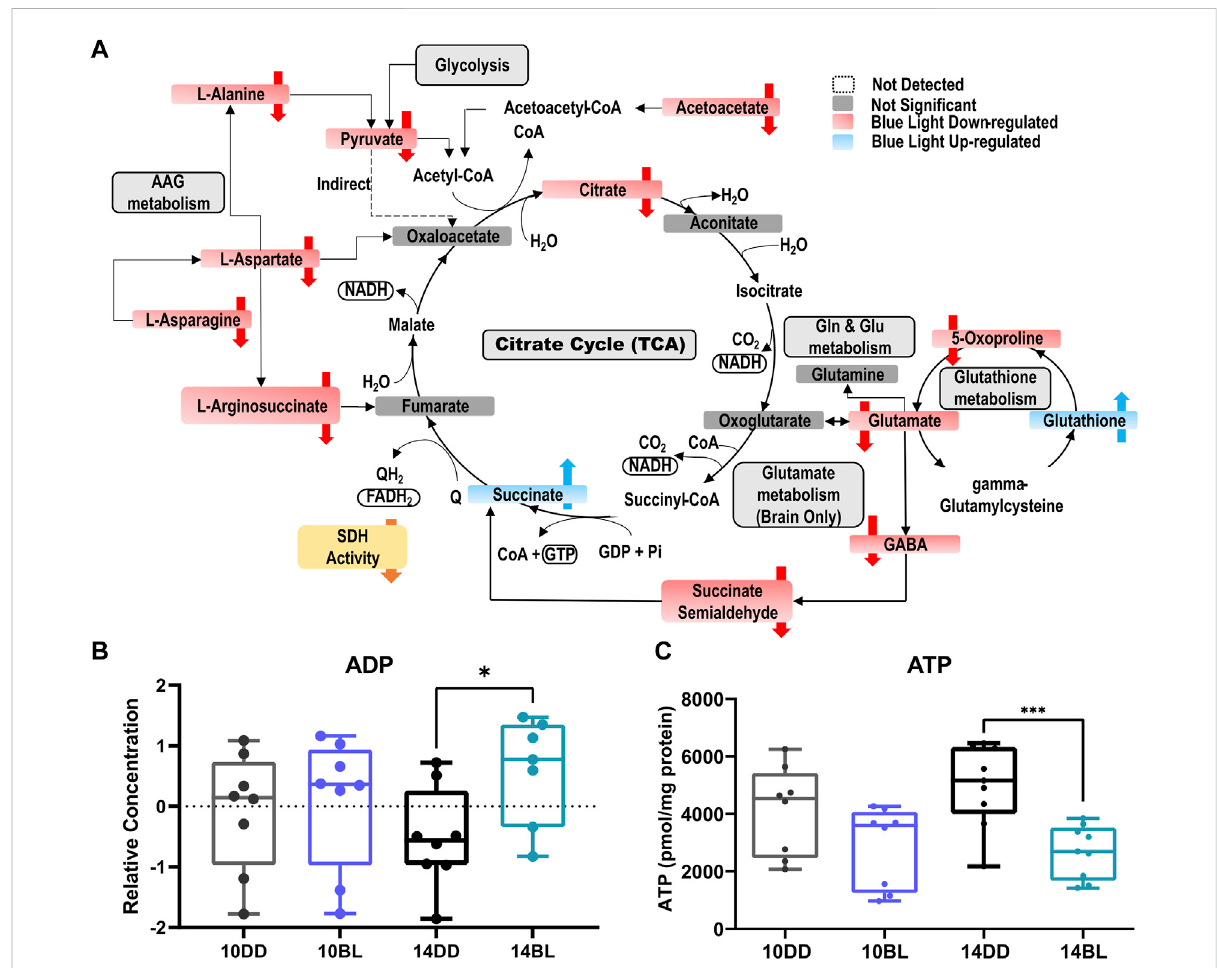
FIGURE 5 Schematicoverview of the metabolic pathways most affected by chronic BL in heads of eya 2 fl ies. (A) Downregulated metabolites are shown in red, and upregulated metabolites in blue. (B) Box plots for ADP levels after 10 or 14 days of chronic BL. (C) ATP levels in heads of fl ies after 10 or 14 days of BL. N = 6 independent biological replicates of 25 fl ies for each condition. Lines in box plot represent max, upper quartile, median, lower quartile, and min from top to bottom. Statistical analysis by unpaired t -test ( ppp p < 0.001, p p <